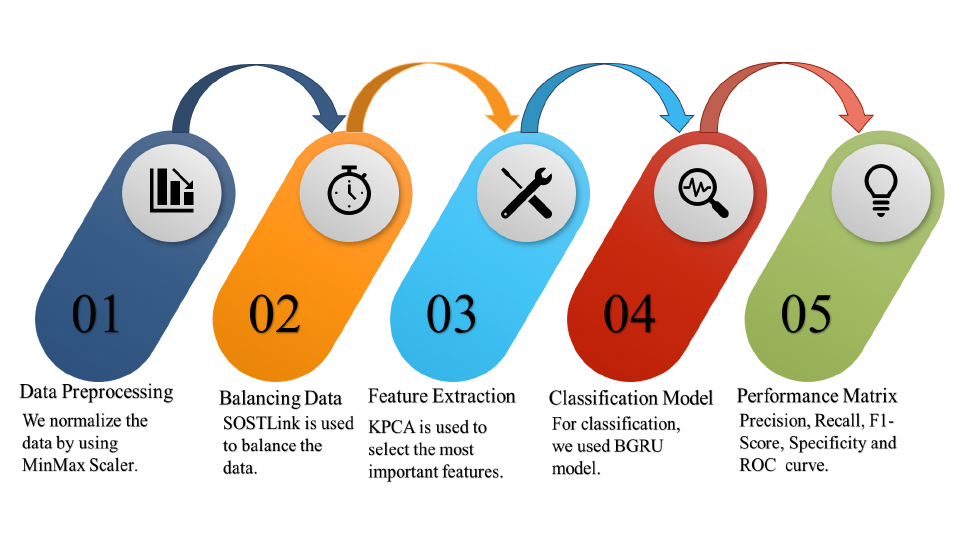
Figure 2. Proposed system